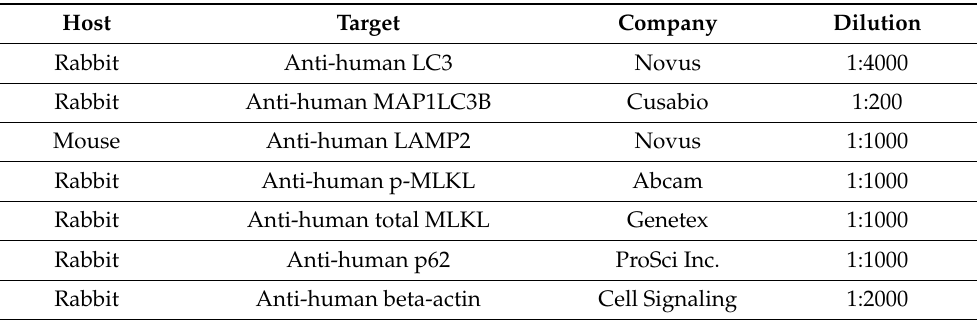
Table 2. Table of primary antibodies. List of antibodies used for Western blotting and ICC staining (including dilutions used and host